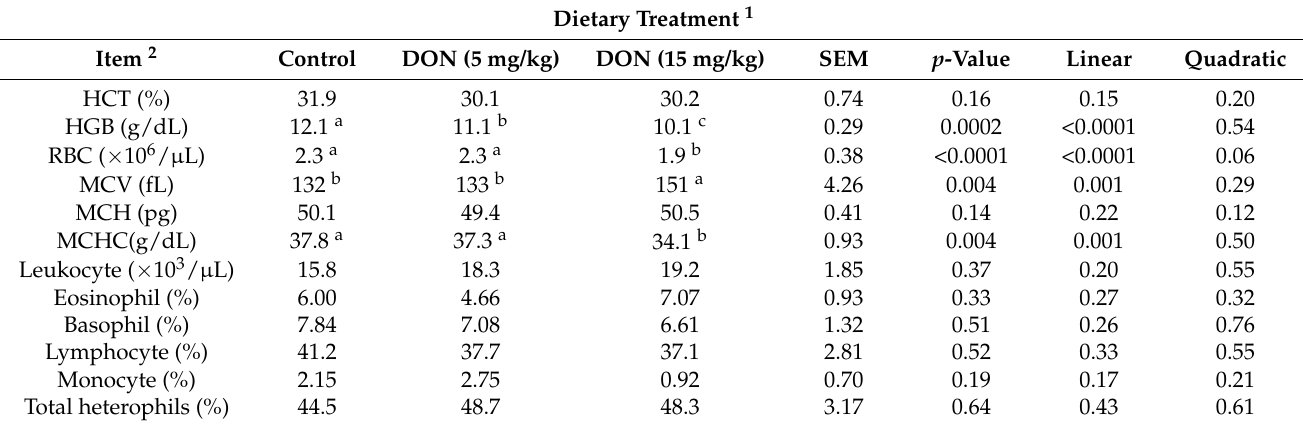
Table 5. Effects of DON-contaminated feed (5 and 15 mg/kg) on hematological parameters of broiler chickens. Dietary Treatment 1